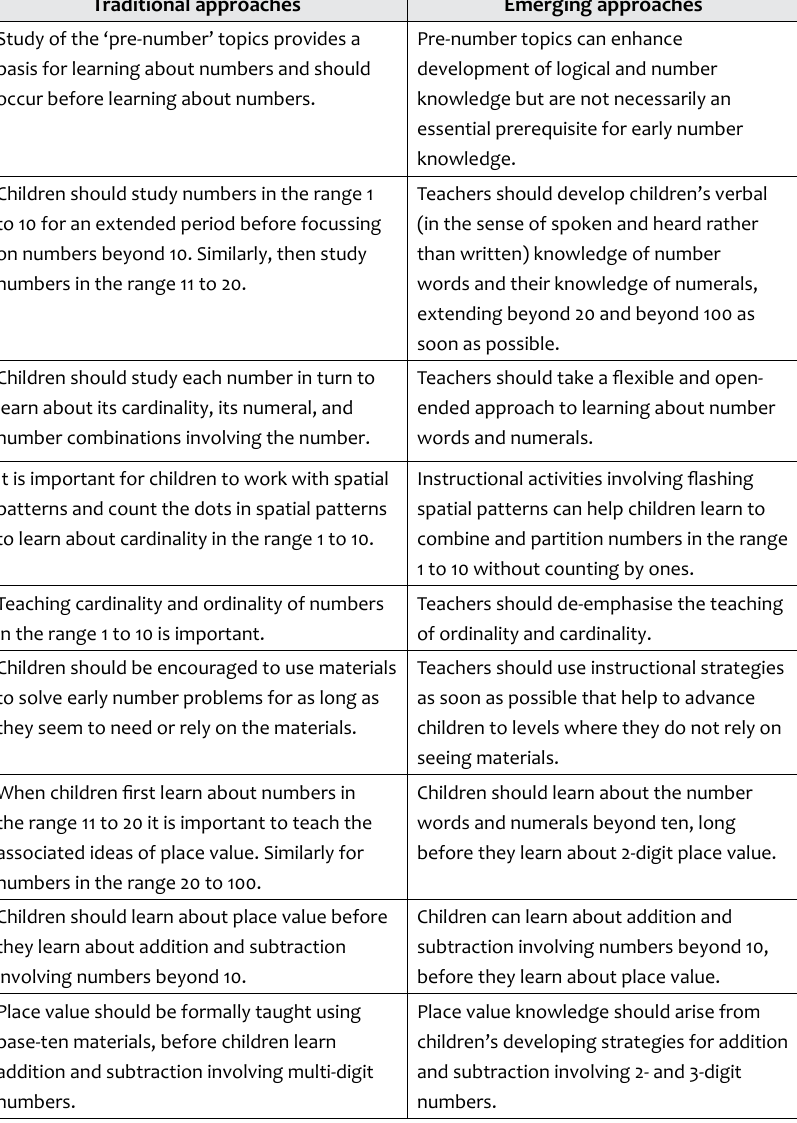
Table 1: Contrasting traditional and emerging approaches to early number